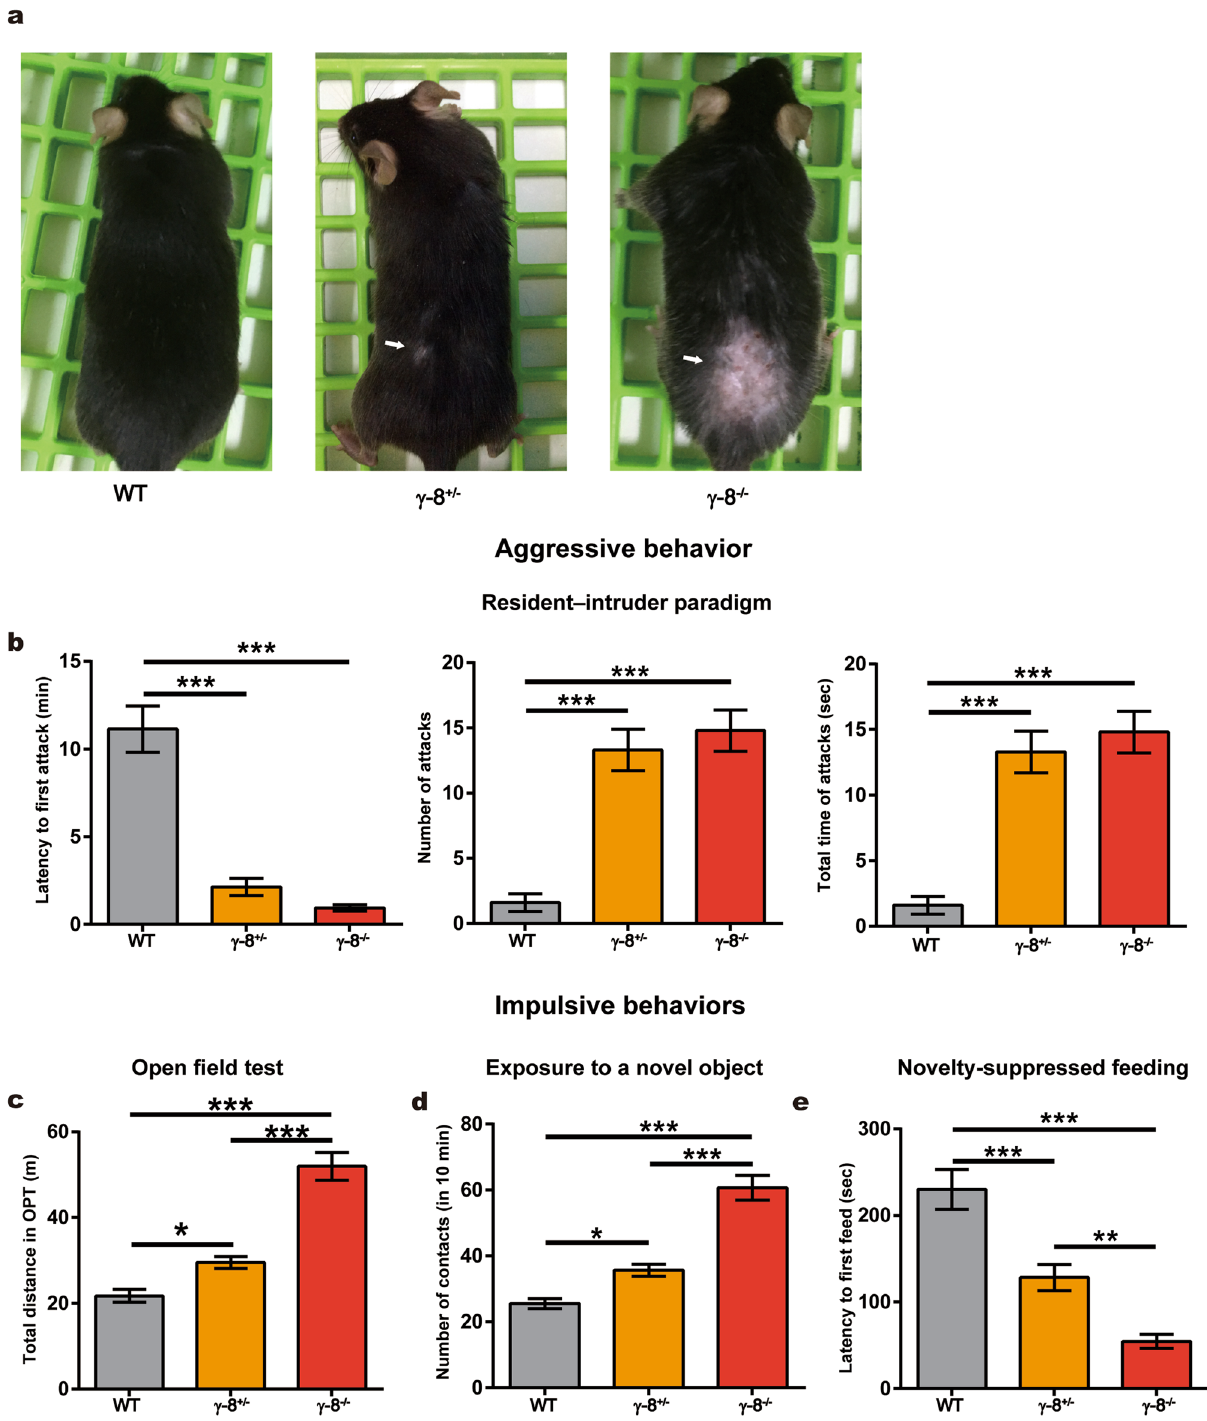
Figure 3. Aggression and impulsivity of WT and mutant mice. ( a ) Representative photos of WT and mutant mice at three-month-old. Four same genotype mice were housed in one cage. The arrows indicate areas where the animal was bitten. ( b ) Aggressive behavior test (resident-intruder paradigm). The latency to the first biting attack (left), the total number of attacks (middle) and the total duration of attack episodes (right) are presented. n = 10 cages (four mice in each cage). ( c – e ) Impulsive behavior tests. ( c ) Open field test. Total distance travelled in 5 min. n = 12. ( d ) The number of contacts with a novel object in 10 min. n = 12. ( e ) Novelty-suppressed feeding test. Degree of hyponeophagia in WT and mutant mice following an 18-h fast. n = 12. Data represent the mean ± s.e.m. one-way ANOVA, * p < 0.05, ** p < 0.01, *** p <